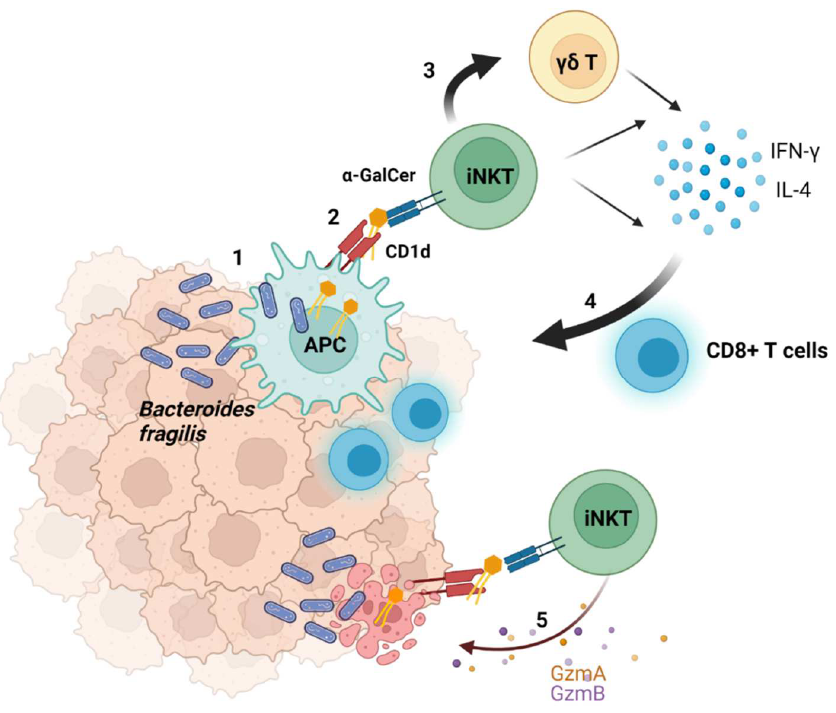
Figure 5. Modulation of the anti-tumor immune response by α -GalCer-producing bacteria. Bacteria infiltrate tumor tissues and are engulfed by antigen presenting cells (APCs) (1). α -GalCer is presented by APCs via CD1d (2) and stimulates iNKT cells to produce lIFN- γ and IL-4. α -GalCer-activated iNKT cells enhance γδ T cell activation and cytokine production (3). These events induce the activation of CD8+ T cells (4). iNKT cells also produce granzymes (Gzms) A and B (5) and may have a direct tumor-killing effect on CD1d-expressing tumors. Illustration was created with BioRender.com (accessed on 22 April 2022).